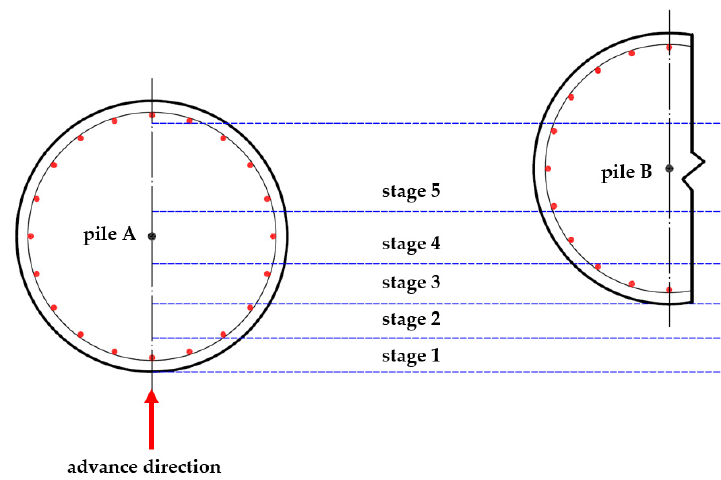
Figure 9. The layout of the test piles.